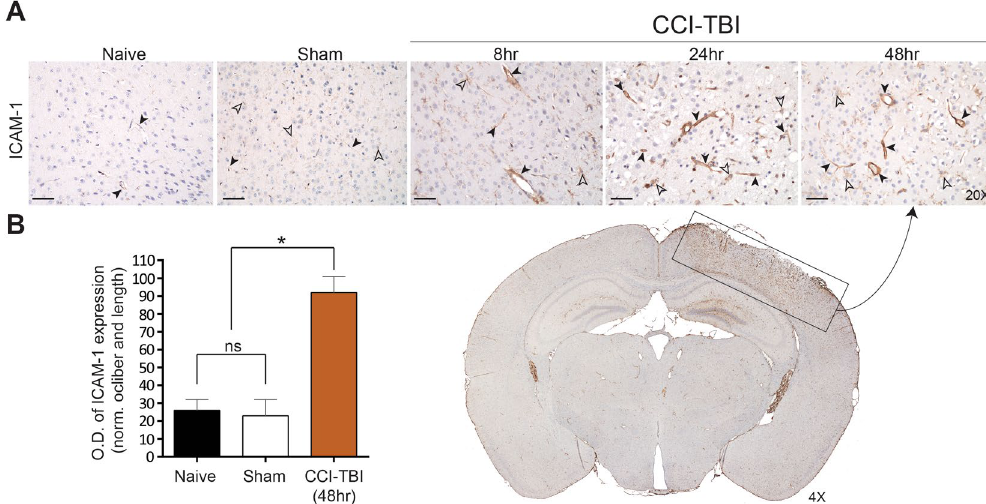
Figure 1. CCI-TBI induces local and temporal increase in ICAM-1 expression in mouse cerebral cortex and underlying brain structures. ( A ) Immunohistochemical detection of ICAM-1 time course of expression in cerebral vasculature (solid arrows) and aberrant expression in astrocytes (open arrows) in area of impact in naive (no craniectomy control), sham (surgical control without impact) and at 8, 24, and 48 hr post-CCI-TBI (20X). Included is a stitched coronal section through the CCI-TBI impact site 48 hrs following CCI-TBI (boxed, 4X). Increased ICAM-1 expression detection can also be visualized in hippocampal regions underlying the impact site. ( B ) Quantification of ICAM-1 staining optical density (OD) normalized to vessel caliber and length for naive, sham, and 48 hr post-CCI-TBI groups. Scale bar equals 50 microns. Data are presented as mean ± SD. (Ordinary one-way ANOVA with multiple comparisons F = 96.35, P <